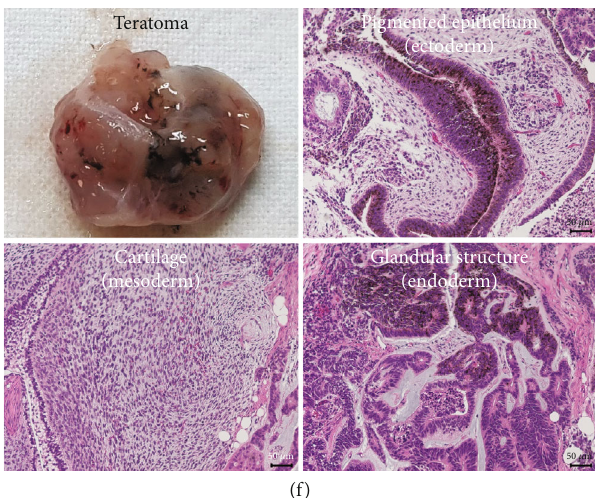
Figure 1: Characterization of human-induced pluripotent stem cells (iPSCs). (a) Undi ff erentiated iPSC colonies. Fully reprogrammed iPSC colonies are round, compact cell aggregates with sharp, distinct borders. Immunostaining of (b) Oct4, (c) Nanog, (d) Sox2, and (e) SSEA4 in undi ff erentiated iPSCs. (f) Teratoma derived from immunode fi cient mice injected with iPSCs. Human-induced pluripotent stem cells from tissues representing embryonic germ layers: pigmented epithelium (ectoderm), cartilage (mesoderm), and glandular structure